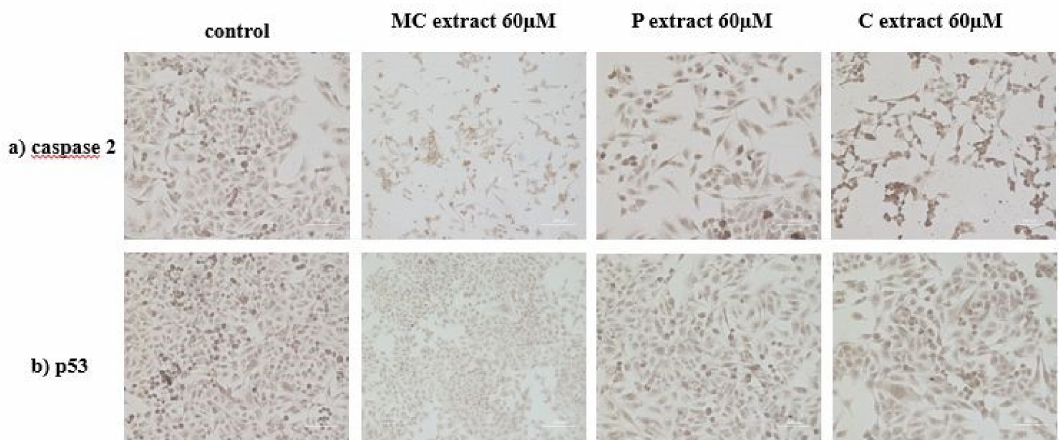
Figure 6. Immunocytochemical evaluation of A375 human melanoma cells after incubation with selected extracts at a concentration of 60 µ M; ( a ) caspase 2 evaluation; ( b ) p53 evaluation (Magnification 10 × ; Scale 200 µ